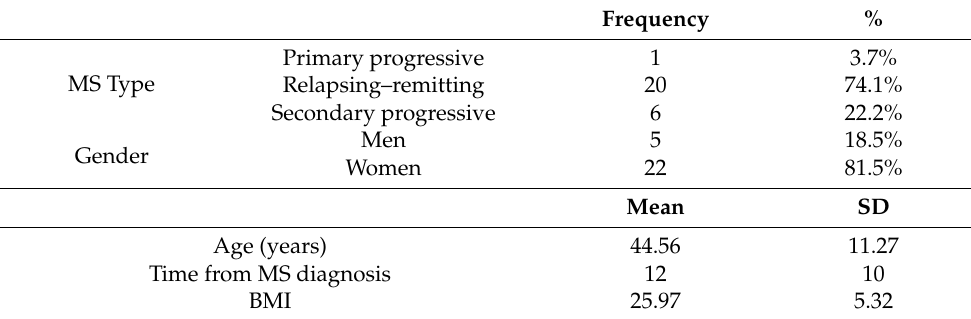
Table 1. Sociodemographic characteristics of the study